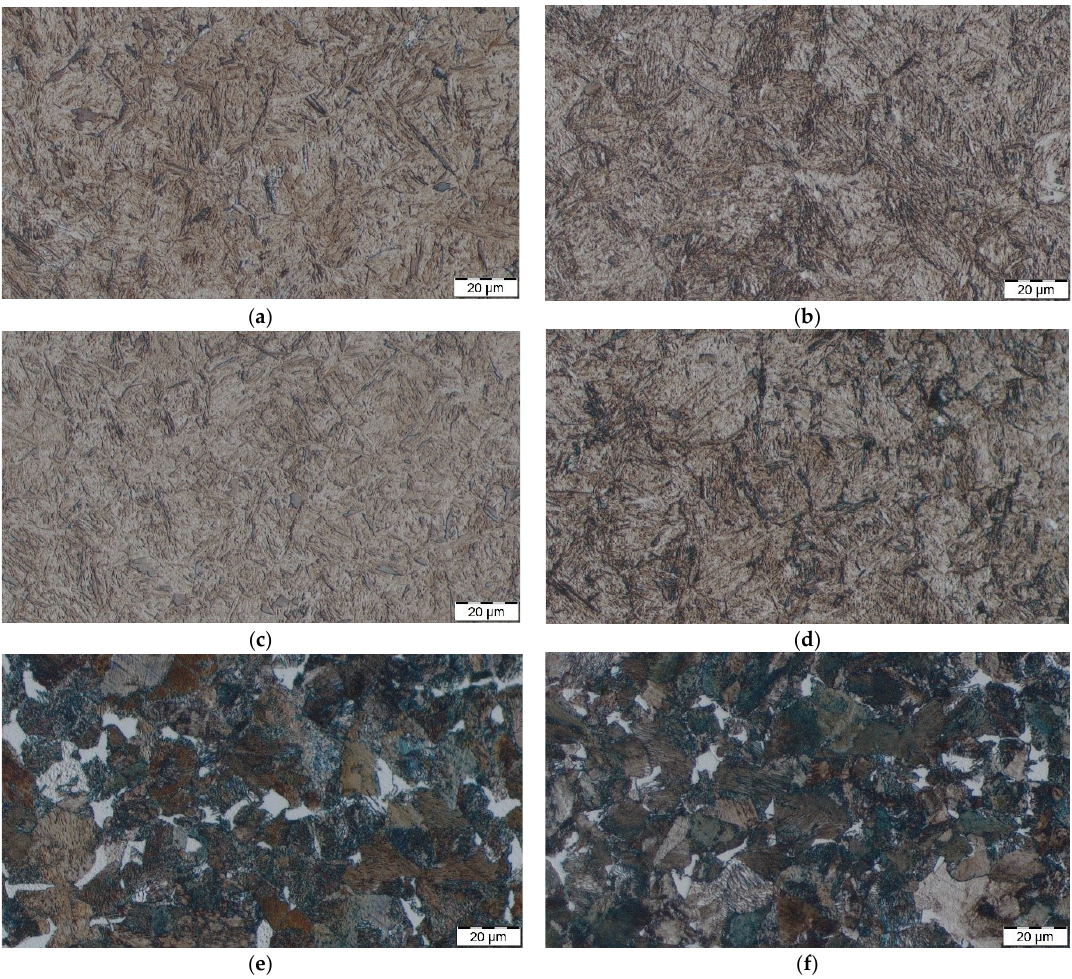
Figure 6. Optical micrographs of 54SiCr6 cooled at ( a ) 100 °C/s, ( b ) 30 °C/s, ( c ) 20 °C/s, ( d ) 10 °C/s, ( e ) 1 °C/s, and ( f ) 0.1 °C/s.